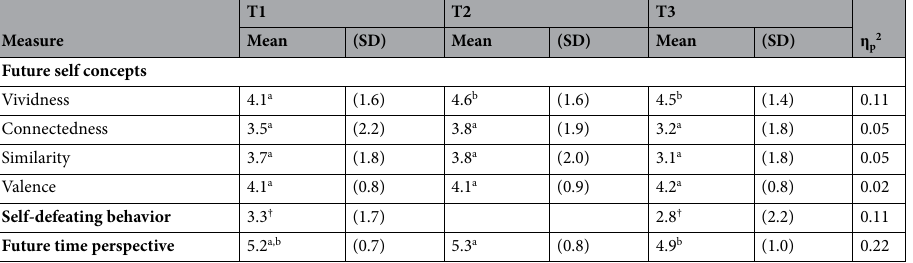
Table 1. Means and SDs of future-self concepts and self-defeating behavior. In total, 24 participants completed T1 and T2; 21 participants completed T3. Means within the same row that do not share the same superscript are significantly different at p < 0.05. † Denotes a non-significant trend at p < 0.10.